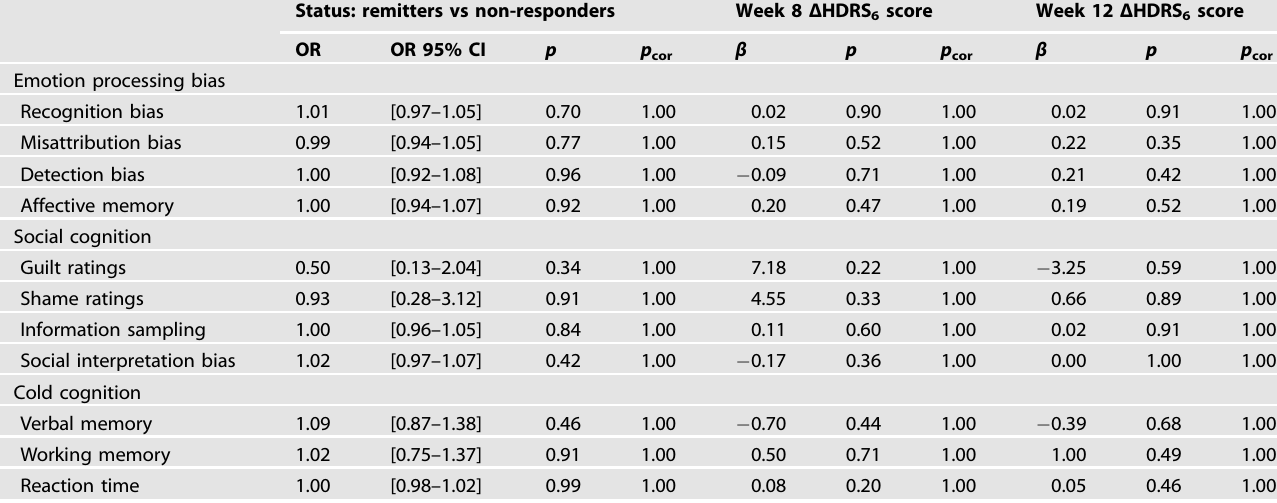
Two outliers were detected for the Simple Reaction Time task (7.2 SD and 3.2 SD above the mean): these two datapoints were capped to 2 and 1 millisecond above the third highest score respectively. To control the family-wise error rate, signi fi cance thresholds in analyses that included all 11 task outcomes were adjusted for 11 tests using the Bonferroni – Holm method [25].